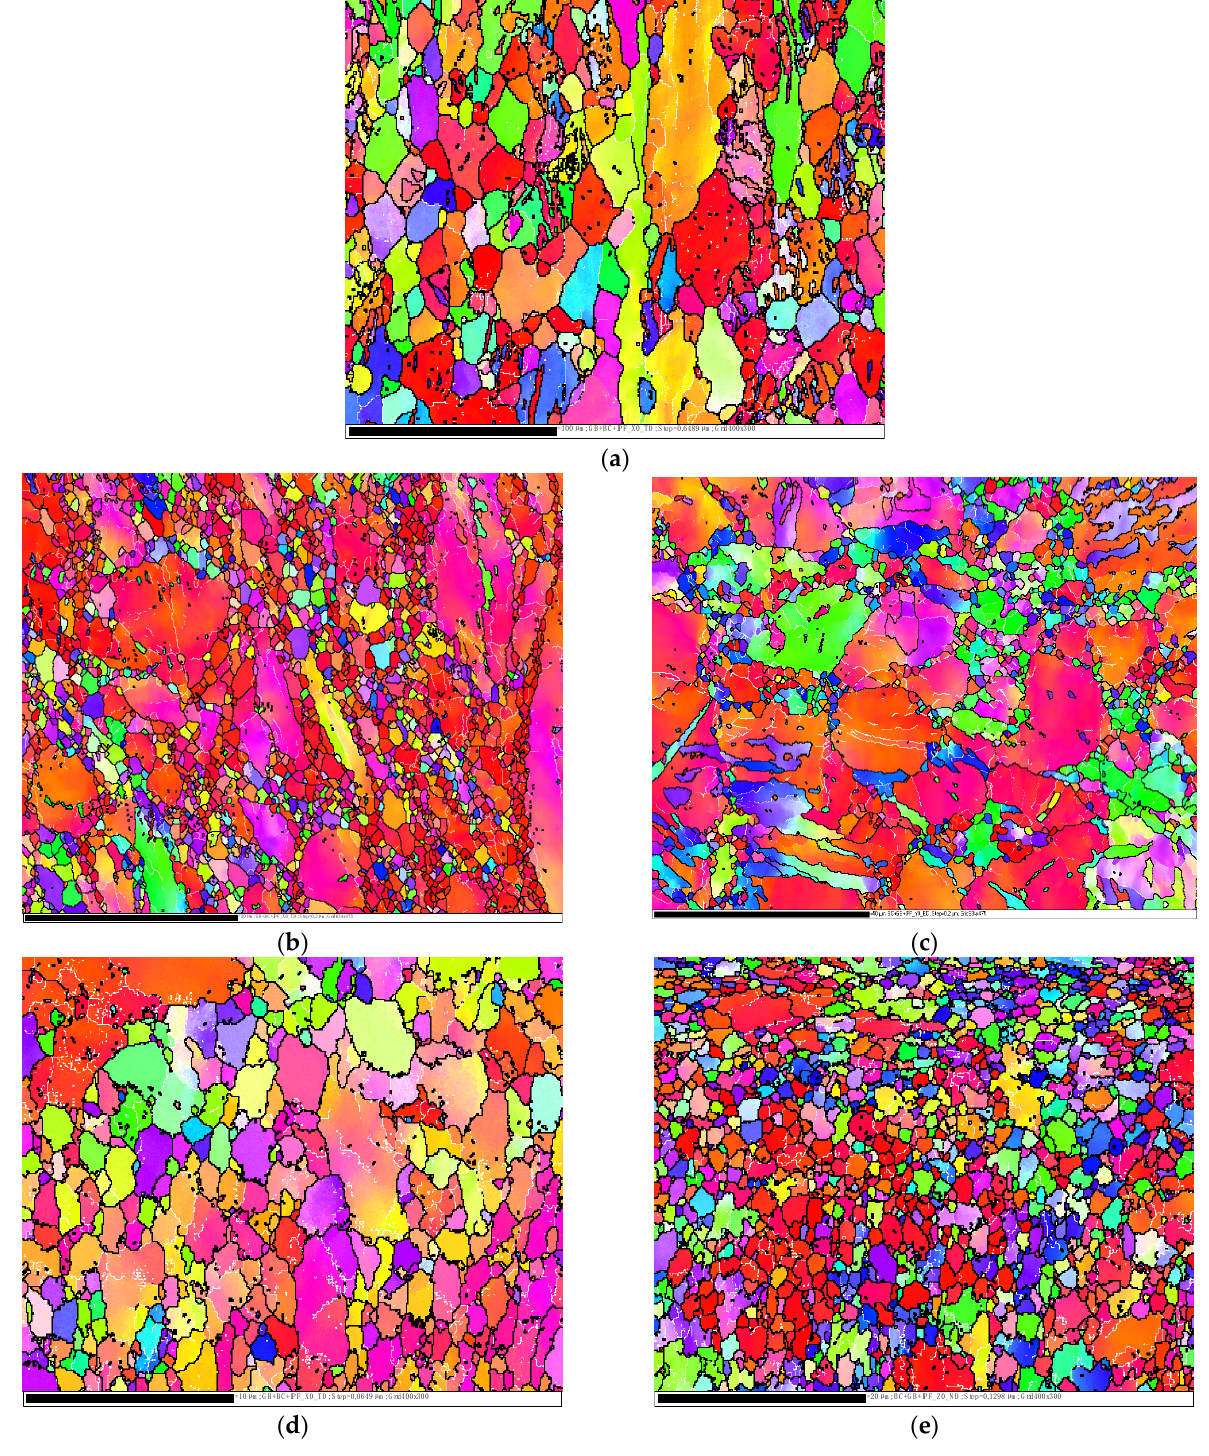
Figure 2. EBSD inverse pole figure (IPF) maps for the AA-Mg ( a ), and after the ECAP processed using route Bc for different passes, ( b , c ) 1P, ( d , e ) 4P, with different die angle, ϕ = 90° ( b , d ) and ϕ = 120° ( c , e ).